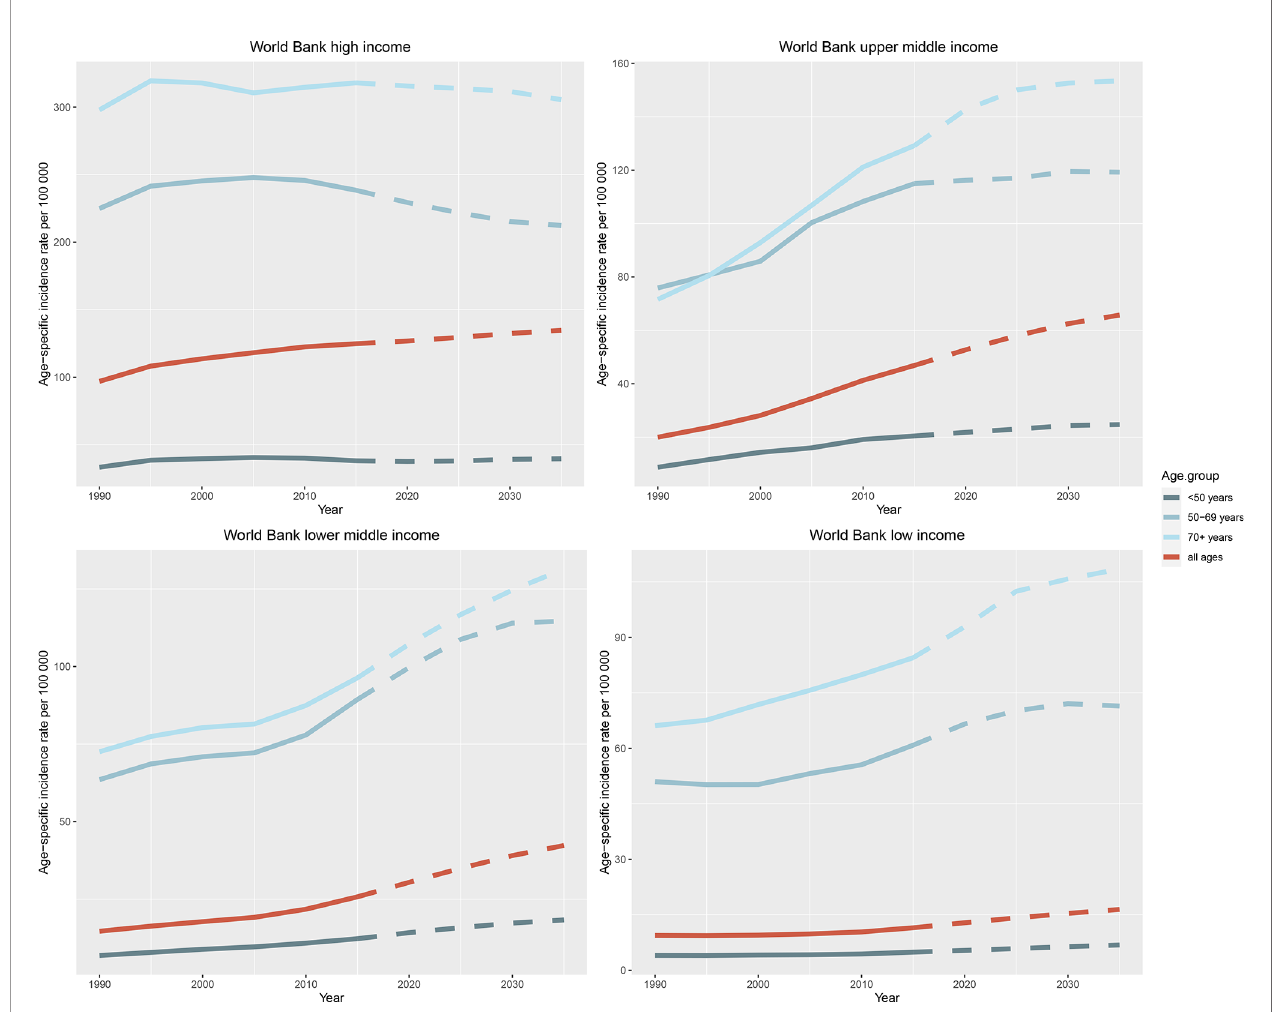
FIGURE 6 | Trends in age-speci fi c incidence rates of female breast cancer in four World Bank income regions by age group from 1990 to 2035. Note: Observed rates are plotted with solid lines and predicted rates are plotted with dashed